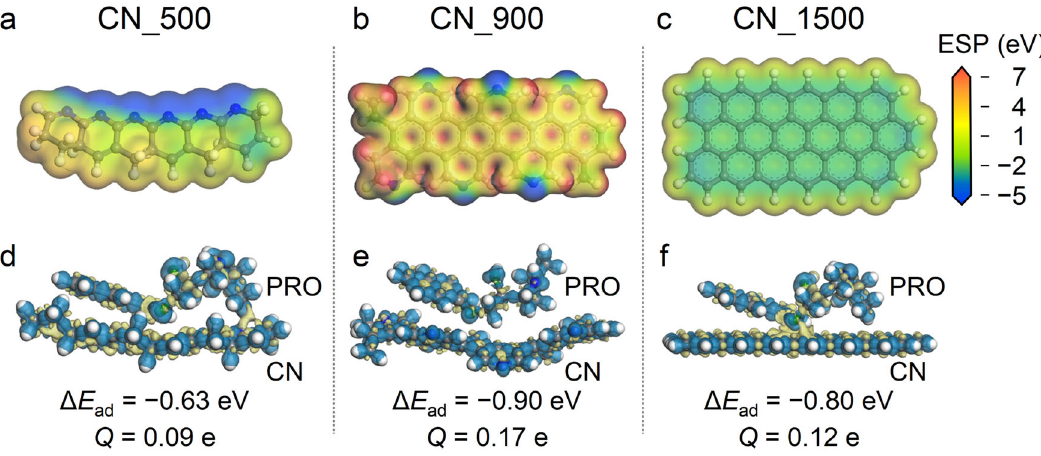
d CN_500, e CN_900,and f CN_1500,respectively;thecalculatedadsorptionenergy ( Δ E ad ) and electron transfer number ( Q ) were